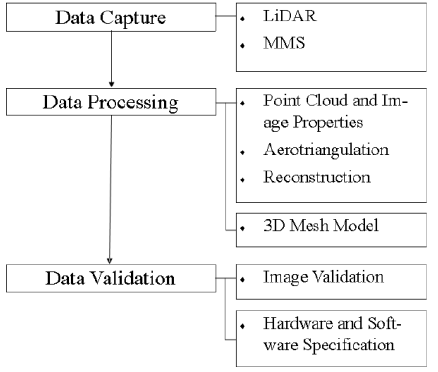
Figure 1: Flowchart of the